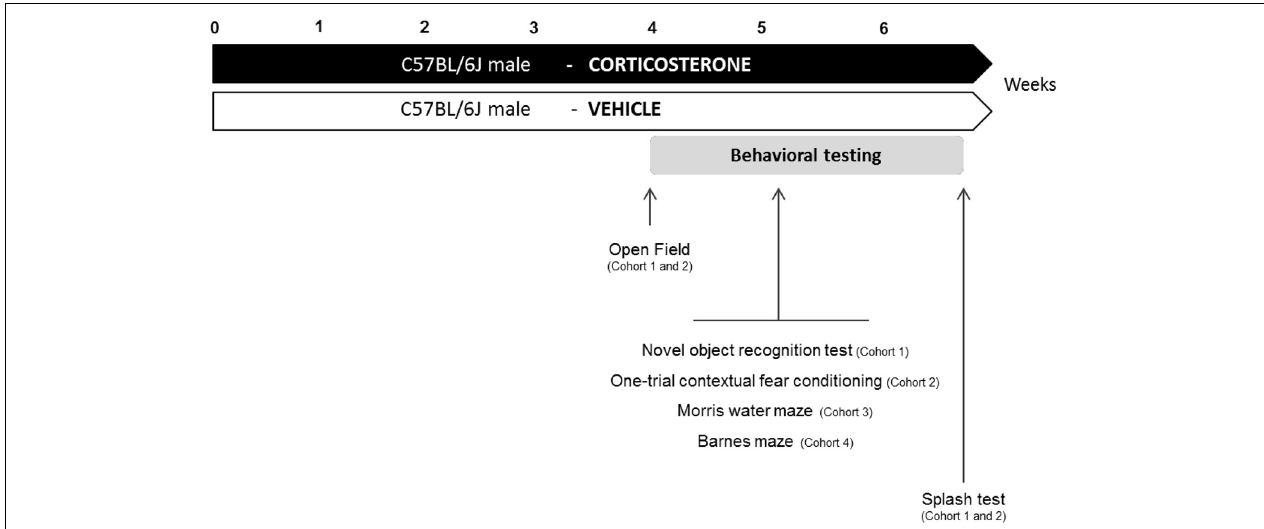
FIGURE 1 | Experimental design. In place of normal drinking water, grouped-housed male C57BL/6J mice were presented with vehicle (0.45% hydroxypropyl- β -cyclodextrin) or corticosterone (35 μ g/mL). We performed a complete characterization of cognitive functions in four different cohorts